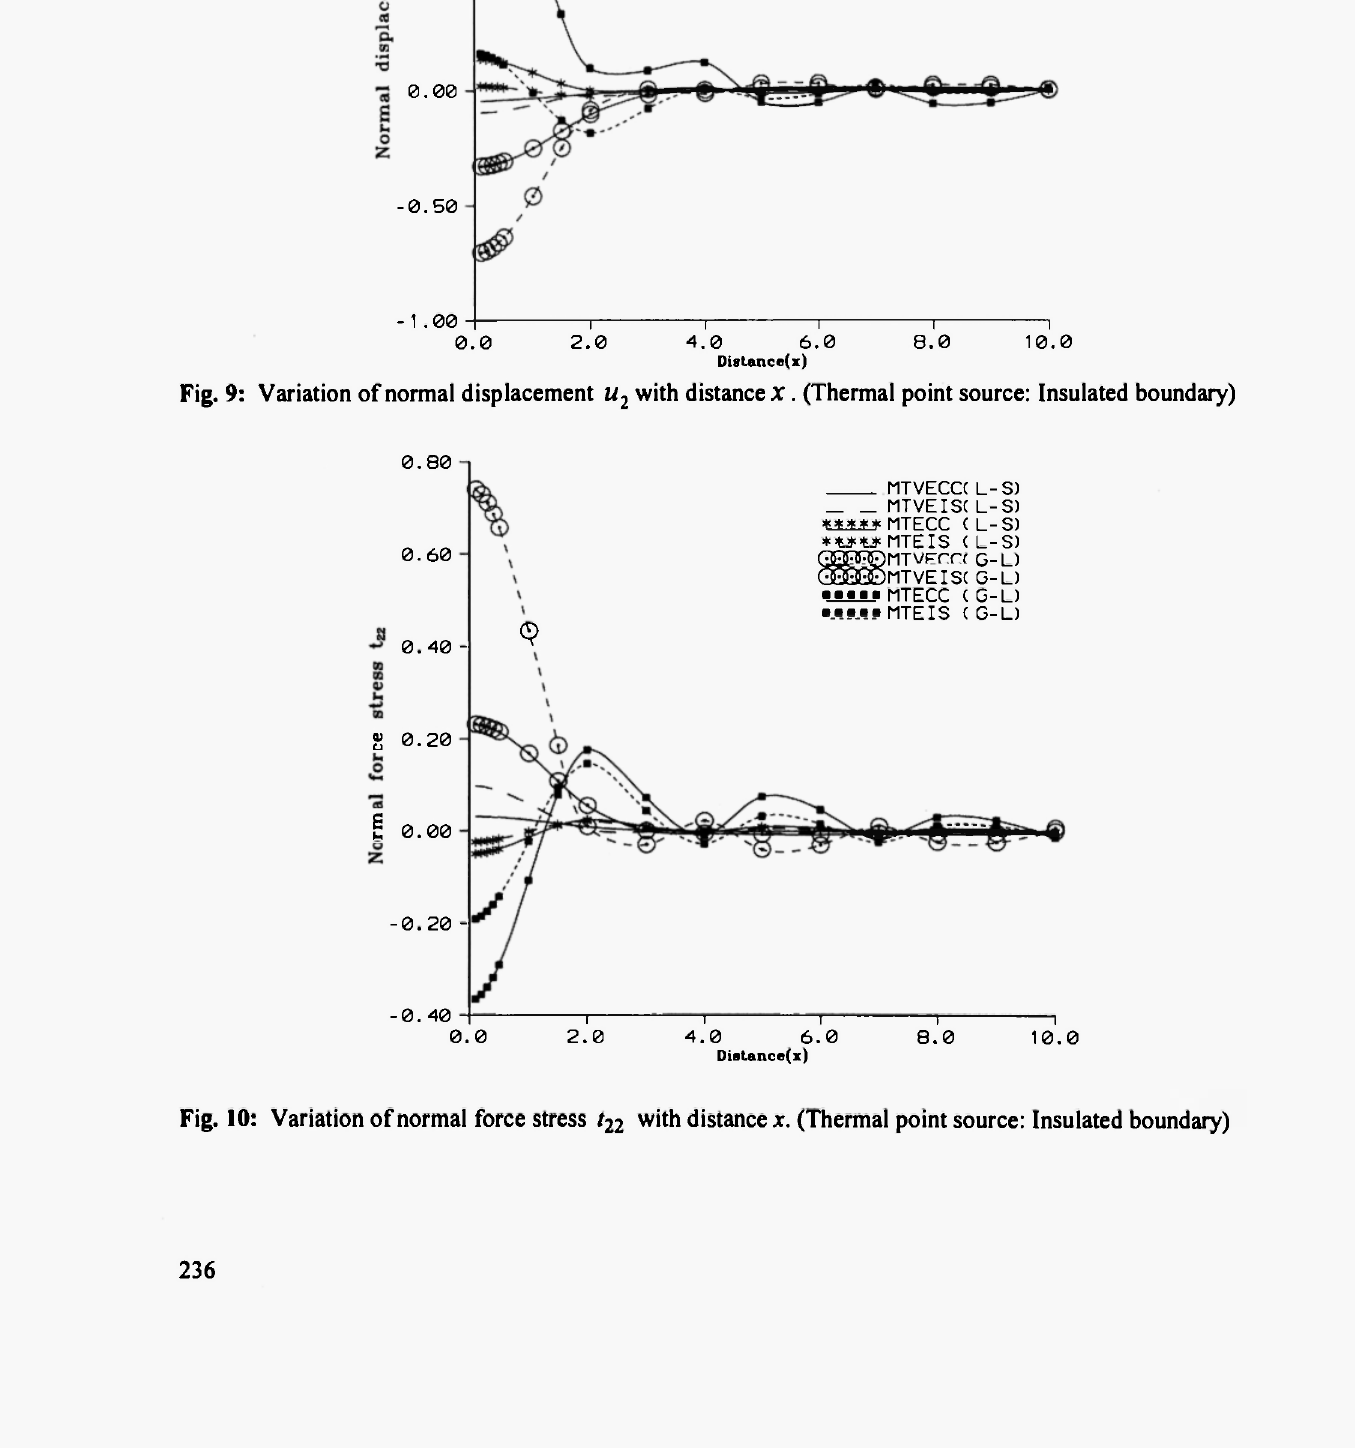
Fig. 9: Variation